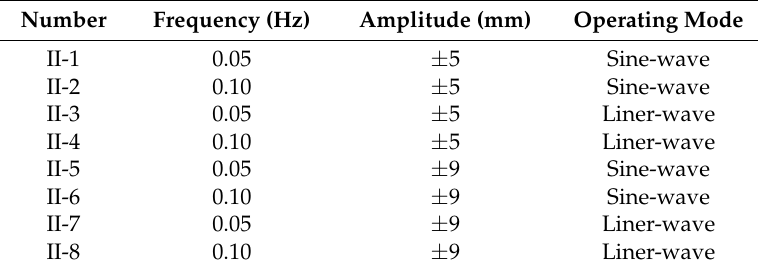
Table 6. Experimental parameters of free target tests.